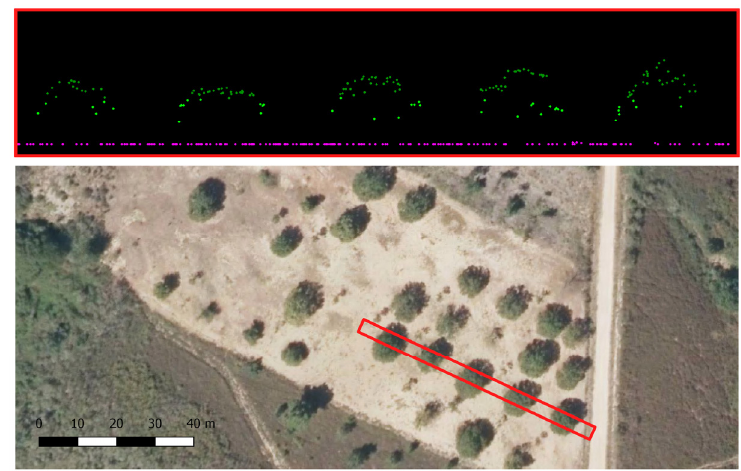
Figure 3. Front view of the normalized Light Detection and Ranging (LiDAR) point cloud corresponding to a chestnut plantation tree line (marked in a red box in the upper image). Orthorectified aerial image of the corresponding chestnut plantation (PNOA image [56]). In the point cloud ground points are represented in pink, canopy points over 4 m in dark green, and canopy points below 4 m in light green.